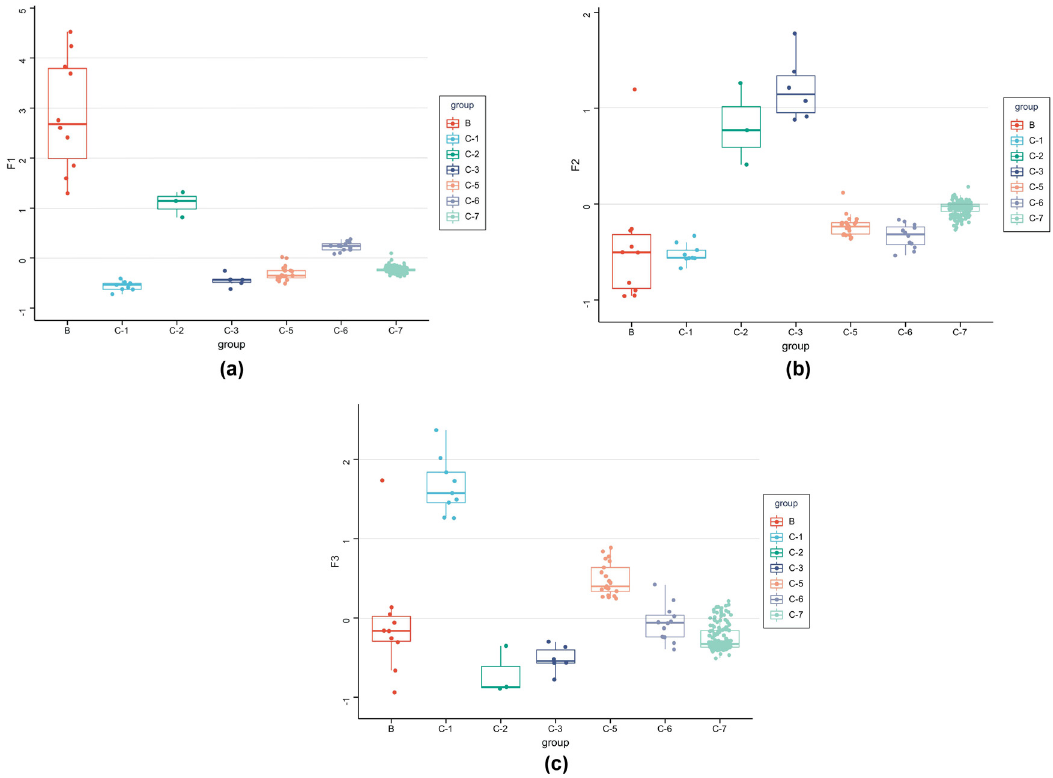
Figure 4: Variation of factor scores in each burial group ( a ) factor 1; ( b ) factor 2; and ( c ) factor 3 ( because of the large factor variation, they are not shown in the box plots to in fl uence the comparison between the small values of other groups ) .